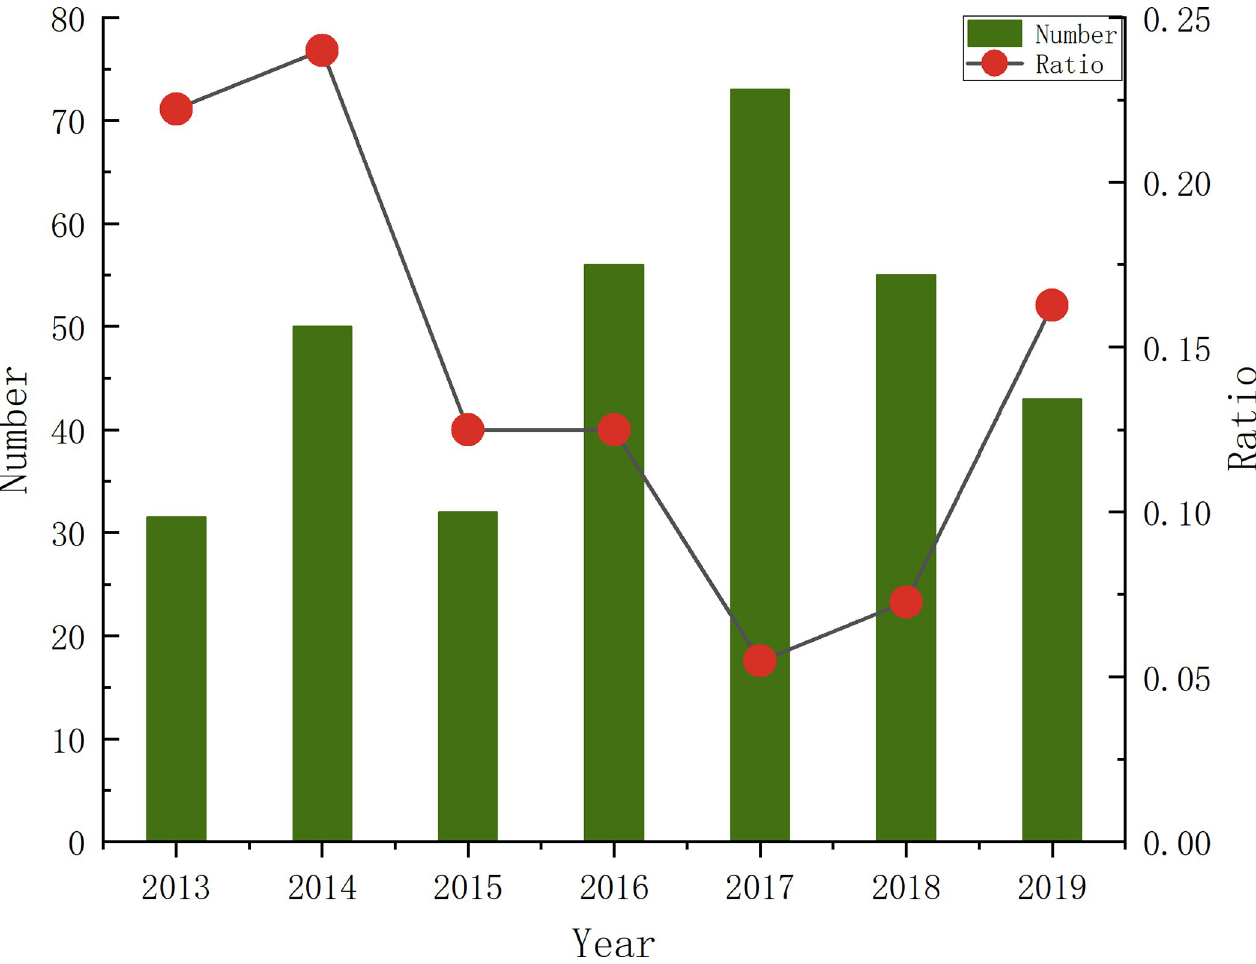
Fig 1. Proportion of heavy accidents and lifting